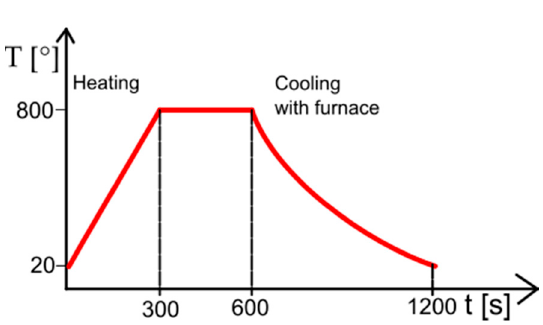
Figure 2. Schematic representation of the hot pressing process.